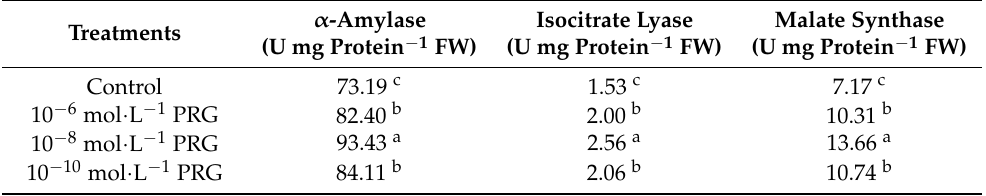
Table 2. Effects of progesterone applications on α -amylase, isocitrate lyase, and malate synthase activities in 4-day-old maize